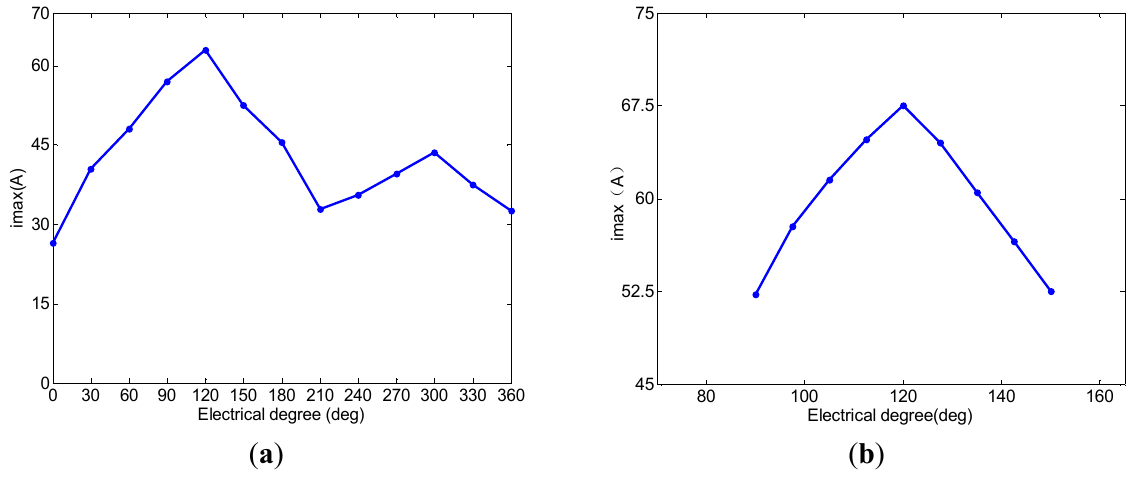
Figure 10. ( a ) Maximum values of 0°–360° current vector response; and ( b ) Maximum values of current vector response after